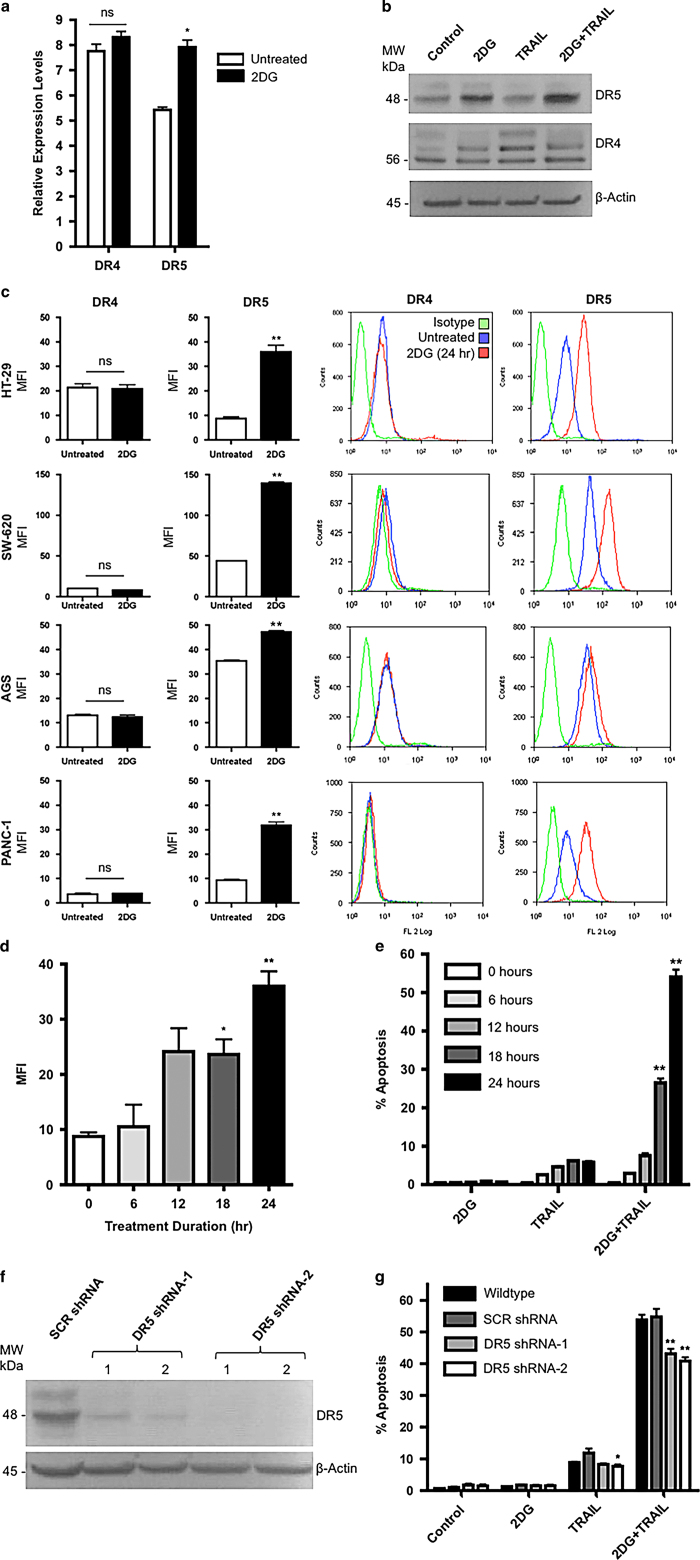
2DG increases DR5 expression levels with no effect on DR4, however, the increase in TRAIL-induced apoptosis requires additional mechanisms. (a) QRT-PCR of DR4 and DR5 transcripts in HT29 cells with and without 2DG treatment. (b) Immunoblotting for DR4 and DR5 indicated increased DR5 protein expression with 2DG treatment. (c) DR surface expression in various TRAIL resistant colon, gastric and pancreatic adenocarcinoma cells. (d) DR5 surface expression increases with 2DG treatment over time in HT-29 cells. (e) Apoptosis, as assessed by capsase-3 activation, in the same group of HT-29 cells increased over a 24 h time course upon treatment with 2DG+TRAIL, corresponding temporally with the increase in DR5 expression. (f) To knock down DR5 expression, HT-29 cells were transduced with the indicated lentiviral constructs and allowed to grow for 48 h. A lentivirus expressing a scrambled sequence was used as a control. (g) Cell death was significantly decreased with DR5 knockdown in 2DG+TRAIL-treated cells, however, remained significantly higher than wild-type cells treated with 2DG or TRAIL alone. n=3, ** indicates P<0.01, ns indicates P>0.05.